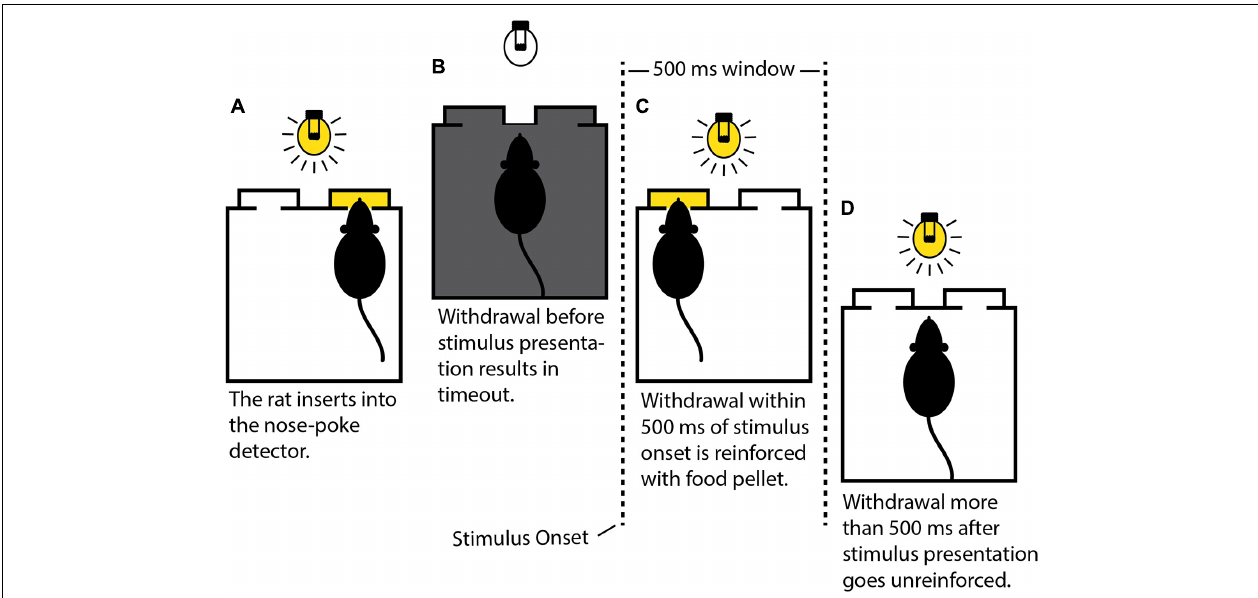
FIGURE 4 | Schematic depiction of the behavioral task. (A) The rat must insert its snout into the nose-poke detector (right side) and maintain insertion uninterrupted until stimulus presentation. (B) Premature withdrawal results in a 7-s timeout during which the house light is extinguished. (C) Withdrawal within 500 ms of stimulus onset triggers the release of a food pellet (left side). (D) Withdrawal outside the 500-ms window results in a 3-s timeout without reinforcement.